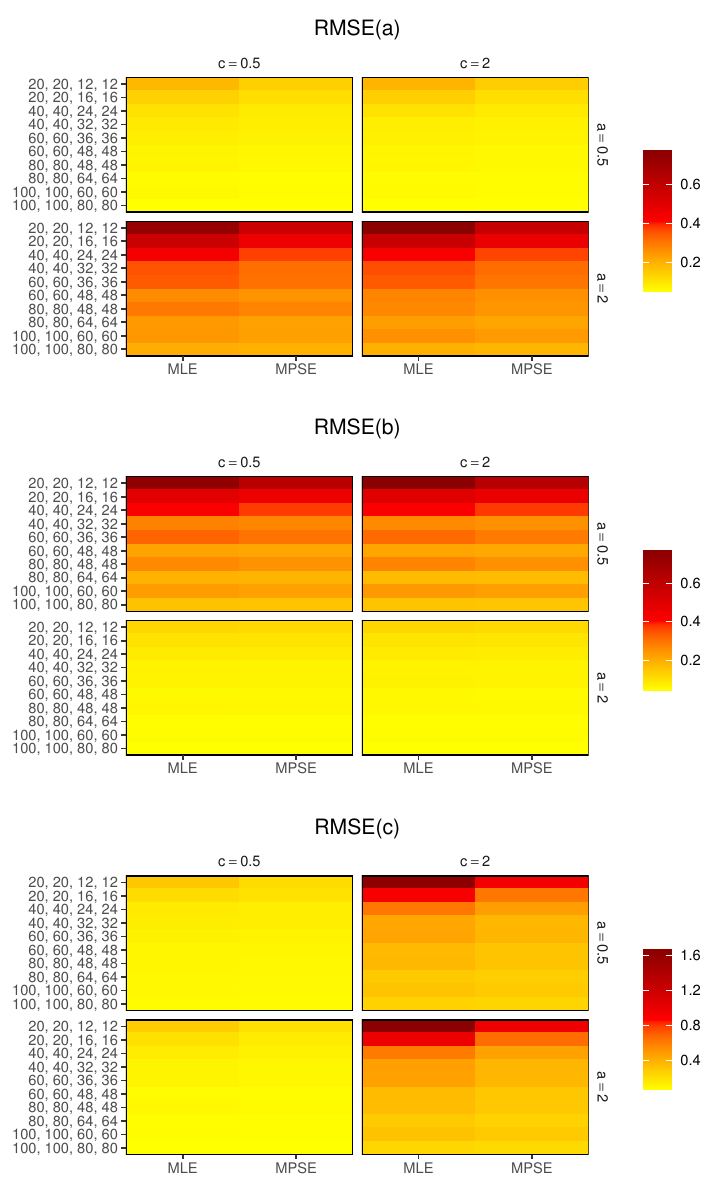
Figure 4. The heatmaps of the simulated RMSEs of the MLEs and MPSEs of a , b and c